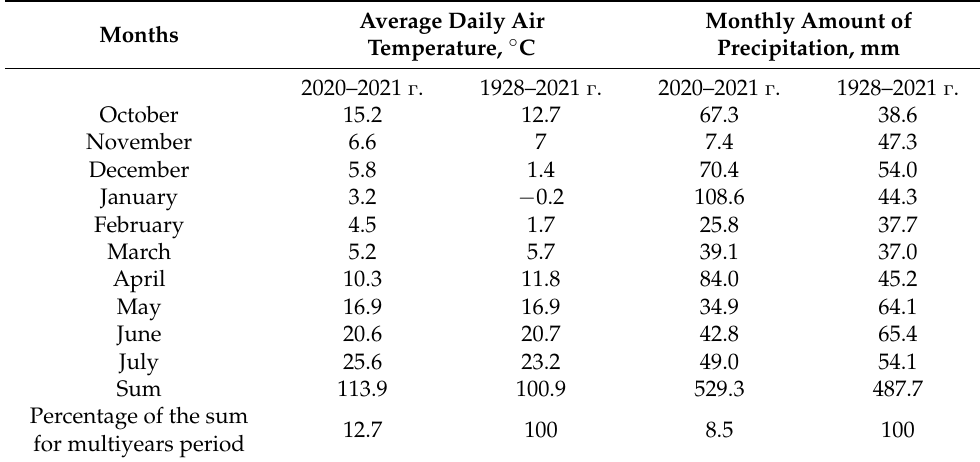
Table 1. Meteorological characteristics during the vegetation of durum wheat in FCI-Chirpan for the 2021 harvest and the average meteorological data for the multiannual period. The data are from the FCI-Chirpan weather station situated less than 500 m from the test site. Average Daily Air Monthly Amount Months Temperature, ◦ C